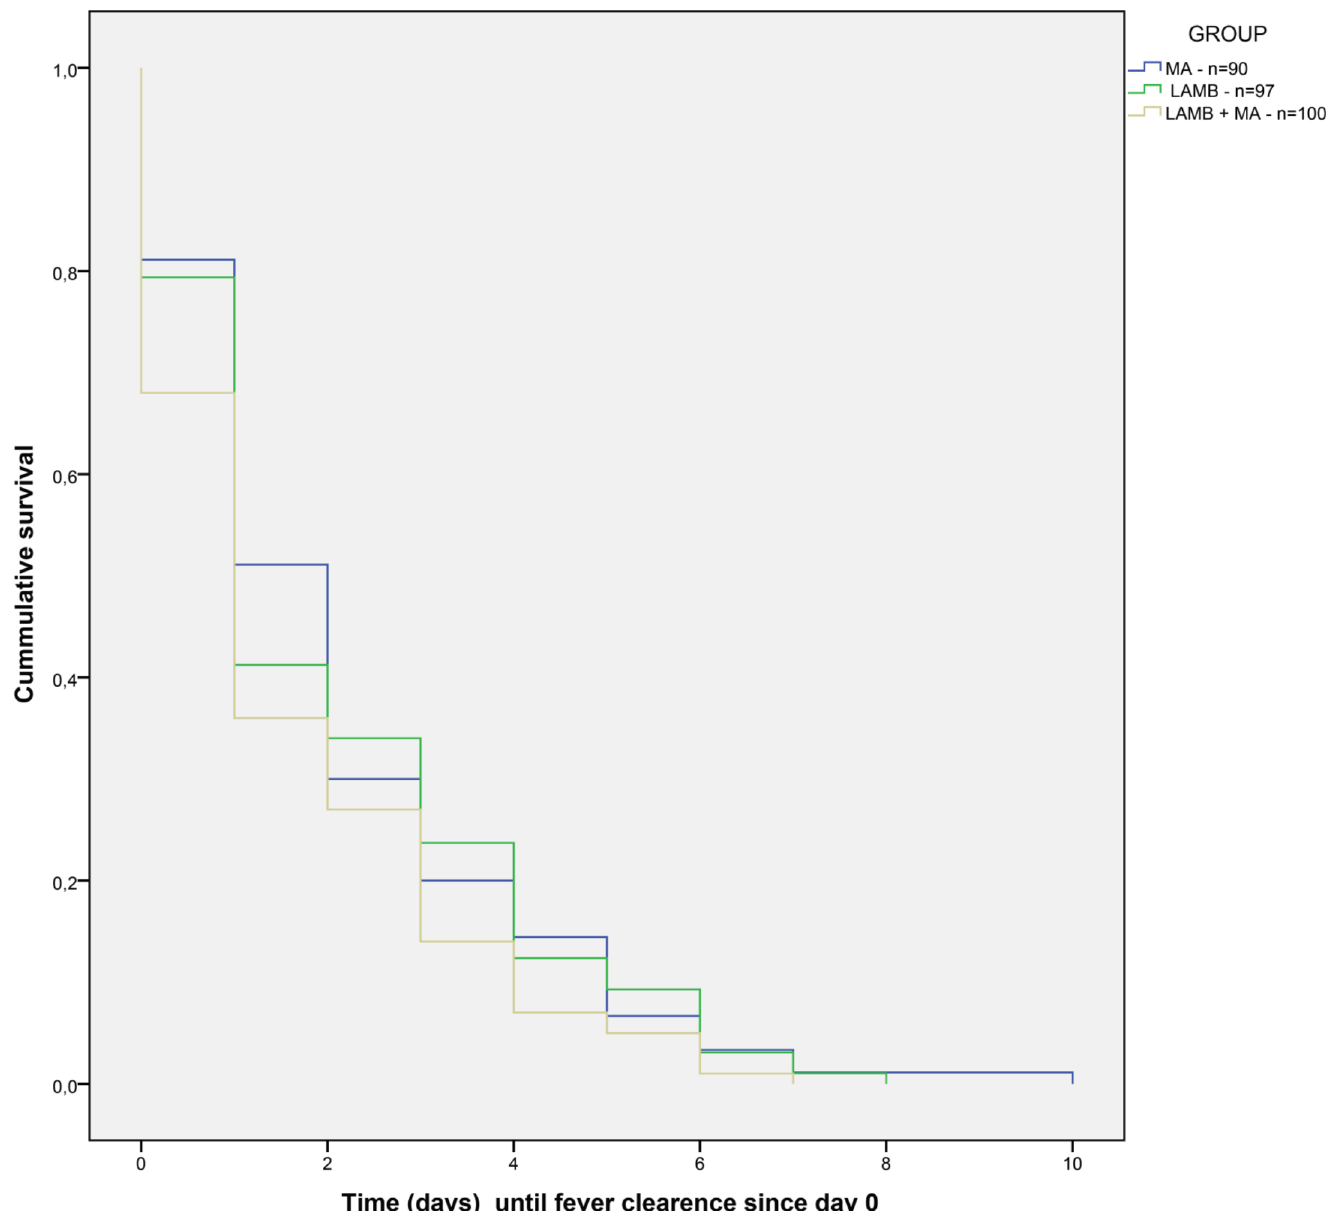
Fig 2. Survival time until fever clearance. Survivaltime until fever clearanceper treatment arm by the KaplanMeier method. MA = meglumine antimoniate; LAMB = Liposomalamphotericin